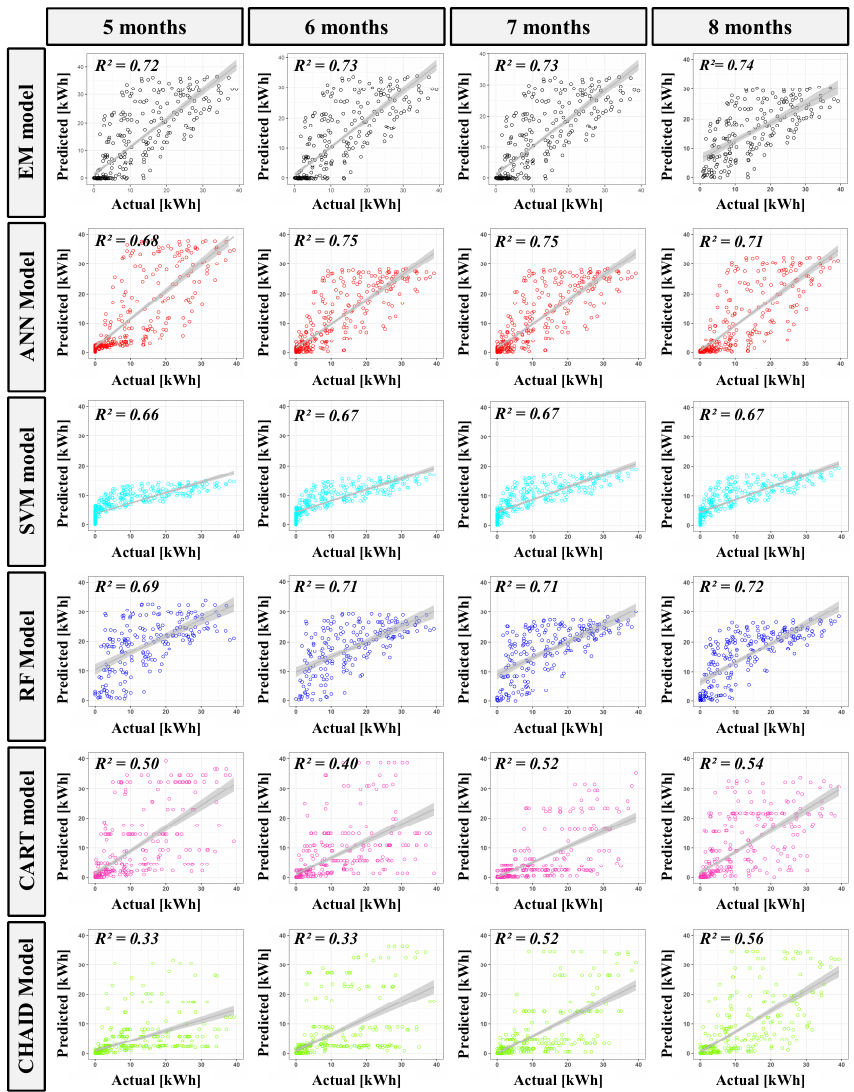
Figure 4. The R 2 values of the six models and plots of actual values vs. predicted values when the training sets were set to 5–8